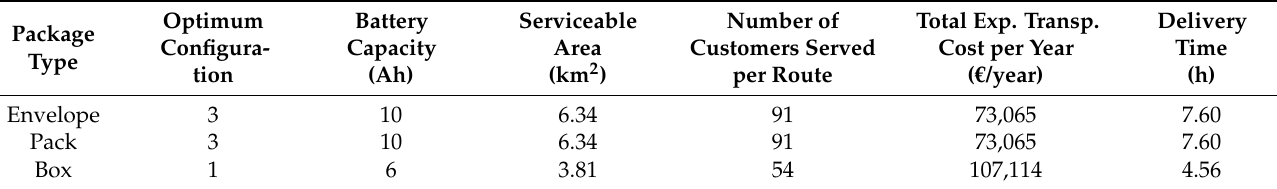
Table 8. Best alternatives with respect to service